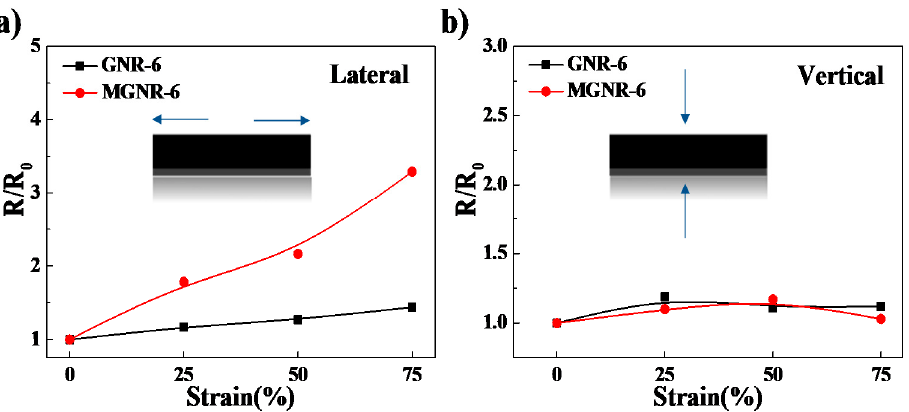
Figure 5. The R/R 0 as a function of the permanent deformation with different strain for MGNR-6 and GNR-6 composites: ( a ) lateral direction; ( b ) vertical direction.